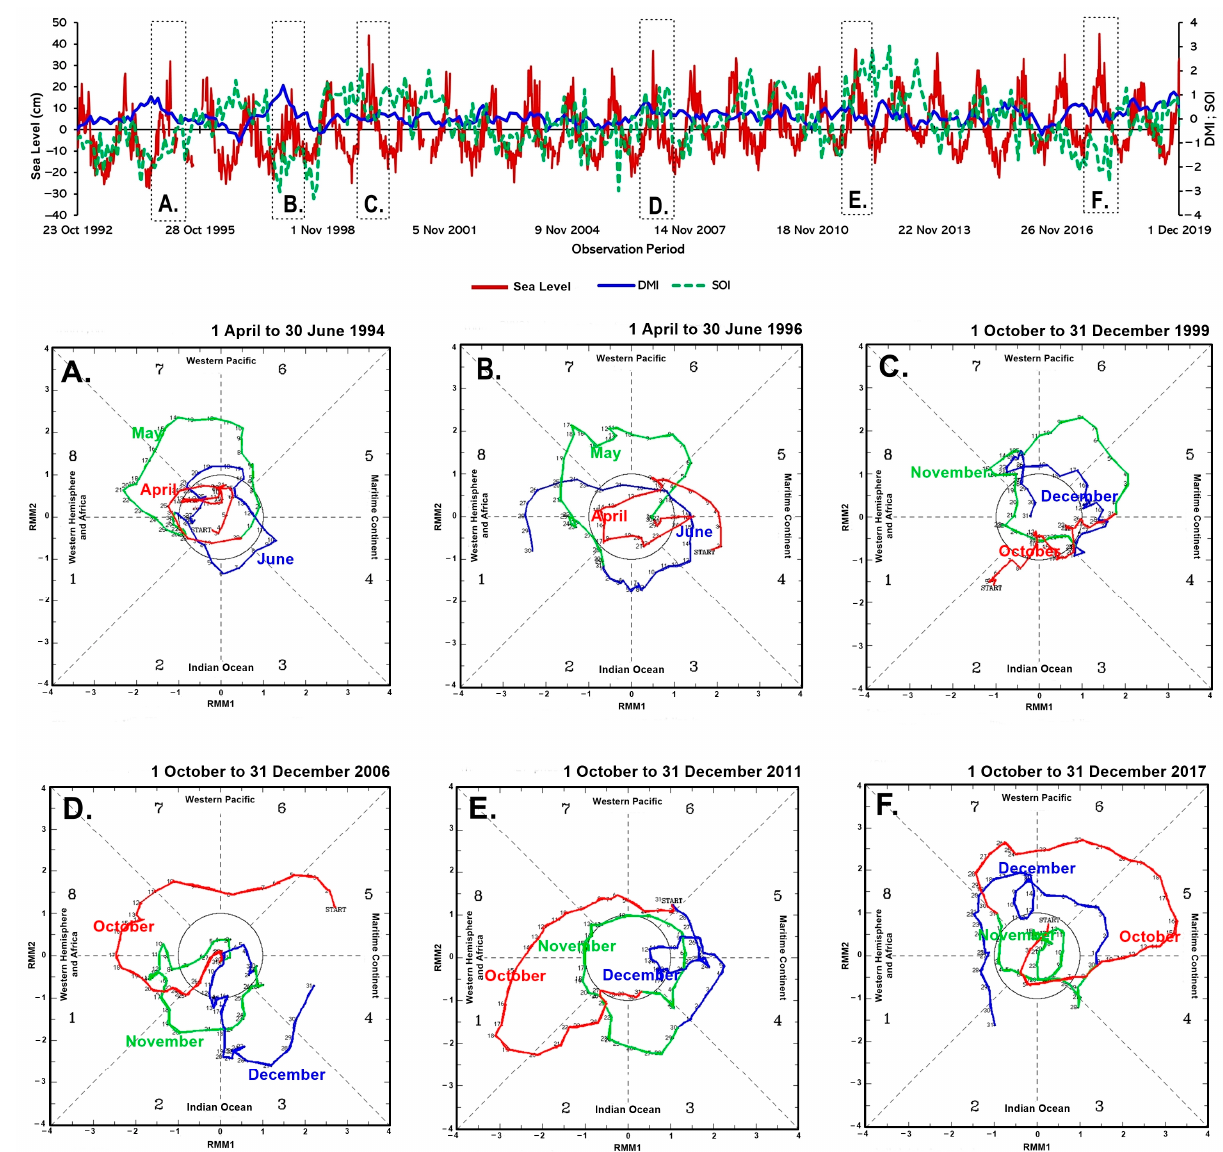
Figure 5. RMM index-determined MJO during the highest phase of sea level over the period of